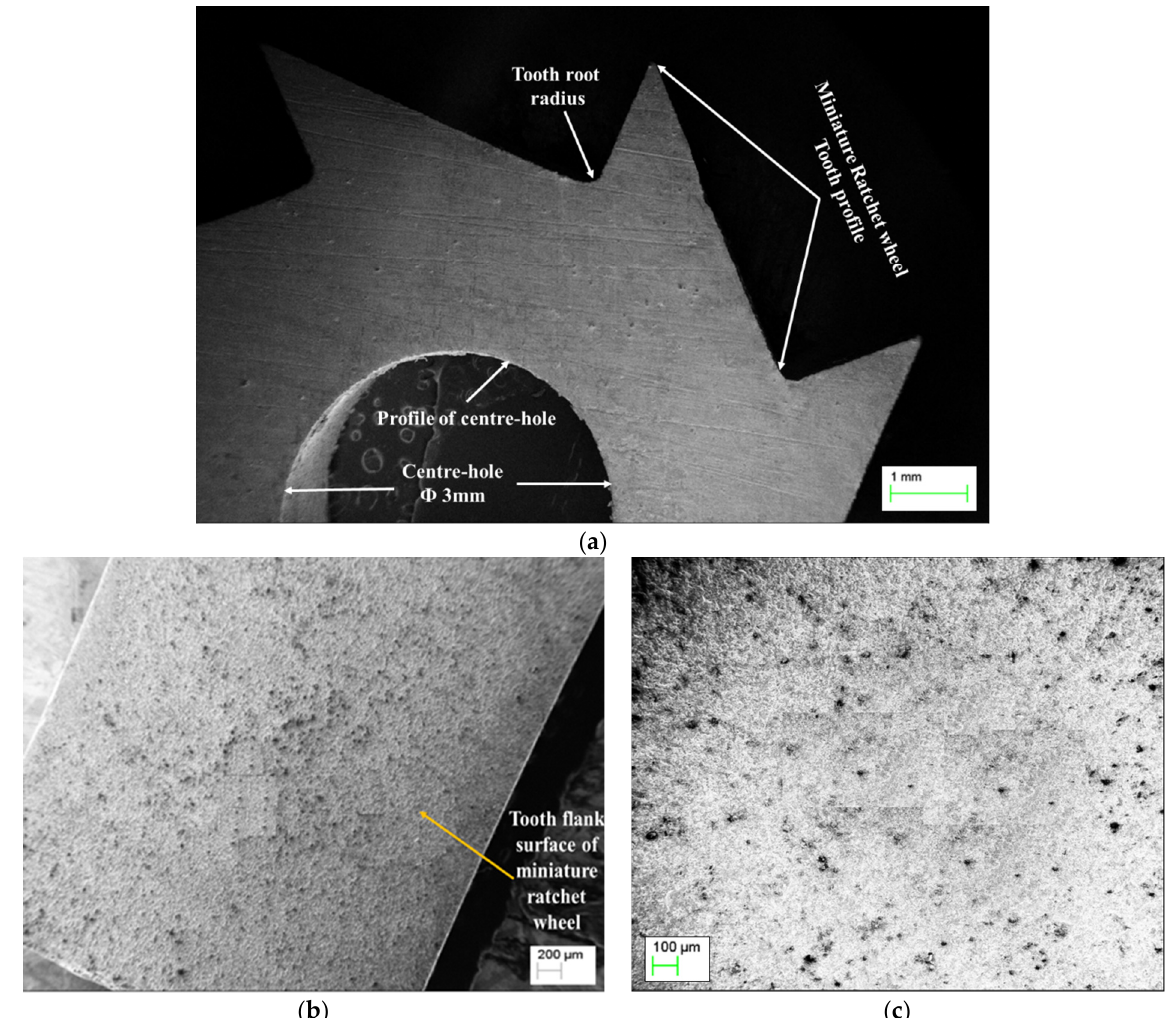
Figure 10. SEM micrographs of miniature-sized ratchet wheel manufactured at optimal parameters of WEDM: ( a ) bore/center hole and tooth profile; ( b , c ) flank surface.